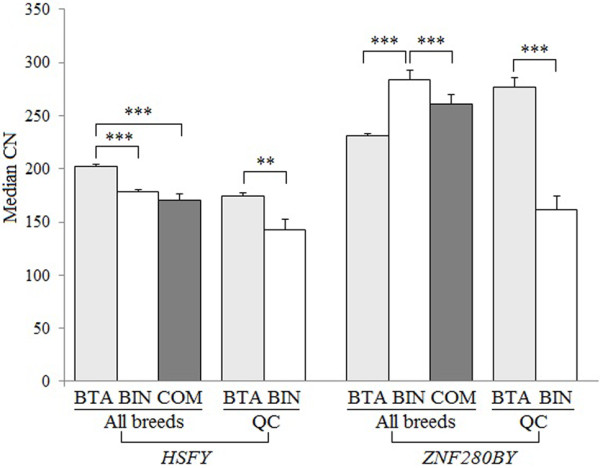
Comparison of the CN of HSFY and ZNF280BY between the BTA and BIN lineages. The CN of HSFY and ZNF280BY was significantly different between the lineages (P < 0.01).The MCN of HSFY in taurine cattle (BTA) was significant higher than that of indicine cattle (BIN) and composite cattle (COM). In contrast, the MCN of ZNF280BY in BIN was significant higher than that in BTA and composite cattle (COM). In the Qinchuan cattle, BTA-derived bulls had a significantly higher MCN of HSFY and ZNF280BY than BIN-derived bulls (P < 0.01). Y-axis represents the MCN of HSFY and ZNF280BY. The error bars represent standard errors. ** P < 0.01; *** P < 0.001.